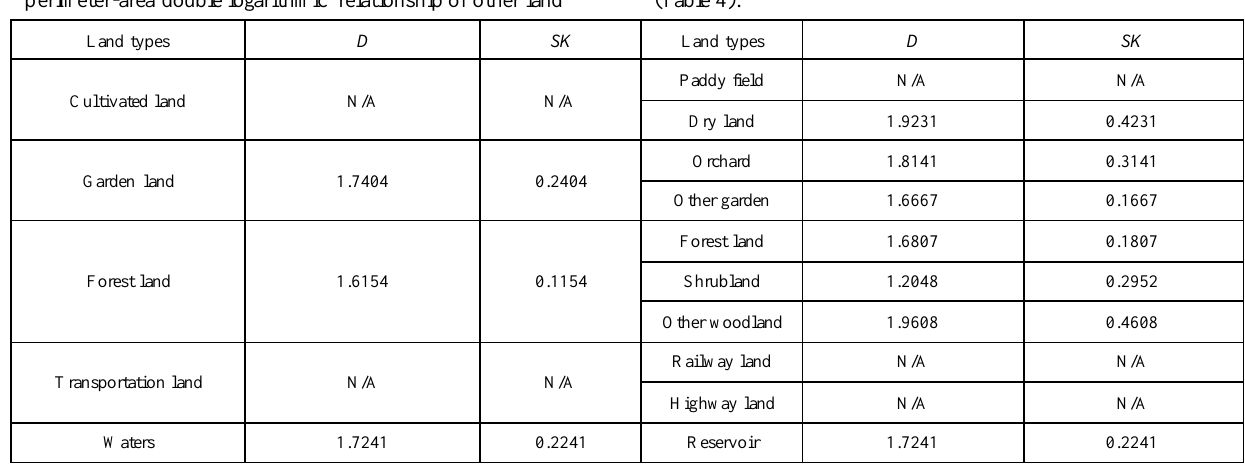
Table 4. The fractal dimension of land-use